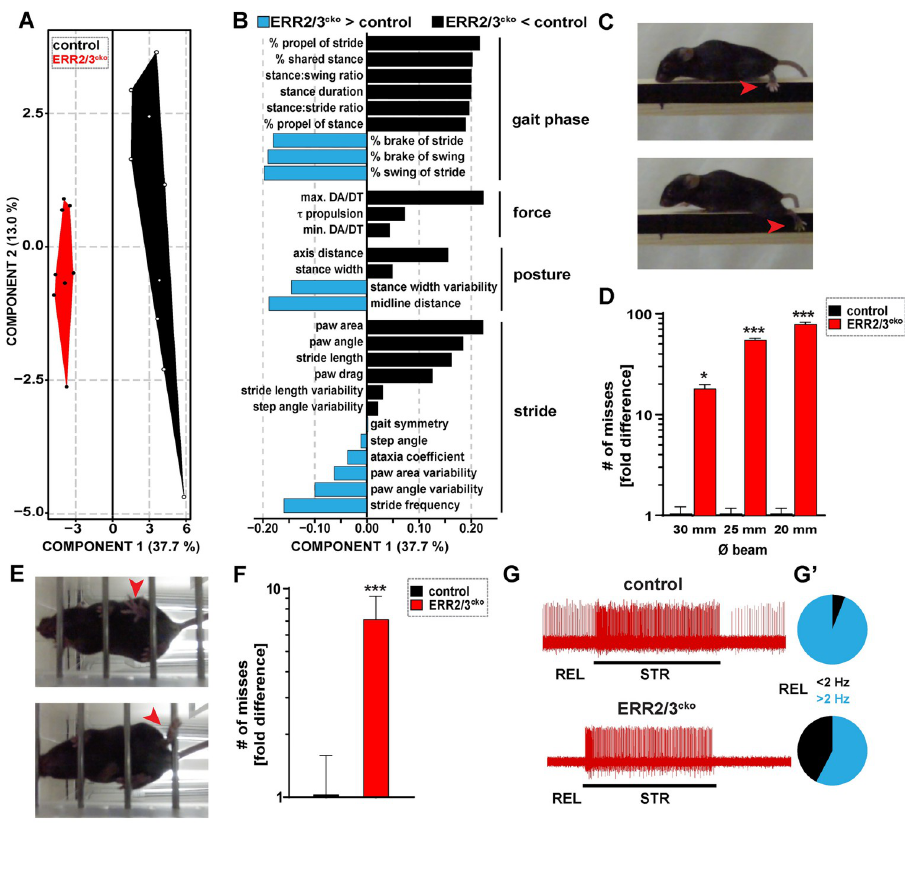
Fig 5. ERR2/3 expressed by gamma motor neurons is required for normal locomotion and precision movements. (A, B) (A) Polygon graphs based on partial least squares (PLS) analysis of 58 gait variables measured during treadmill locomotion at 25 m•s − 1 reveals significant gait alterations in ERR2/3 cko mice ( n = 8, 3 trials/animal) when compared to control mice ( n = 9, 3 trials/animal). Each dot represents a single animal, polygons group animals of the same genotype, the segregation of which along the x-axis indicate that ERR2/3 cko mice exhibit significant gait alterations at all speeds tested (ERR2/3 cko mice, 3 trials each). (B) Negative (black) or positive (light blue) changes (arbitrary units) in gait variables in ERR2/3 cko compared to control mice ranked by predictive value independent of sign, including reduced stance-swing phase ratio (gait phase related), reduced propulsion velocities (force related), decreased stance width (posture related), and increased paw angle variability (stride related). (C) Still images of ERR2/3 cko mouse navigating a horizontal beam. Red arrow: (example of a “miss”): foot missing the beam during swing-stance transition, causing the hind limb and animal to slip during swing phase (red arrow in C ). (D) ERR2/3 cko (18.0 ± 1.75, 55.0 ± 2.20, 79.0 ± 3.49) but not control (1.0 ± 0.175, 1.0 ± 0.125, 1.0 ± 0.125) mice exhibit dramatically increasing erratic locomotion (18-, 55-, and 79-fold increase in the # of misses) upon navigating horizontal beams with decreasing width 30 mm, 25 mm, and 20 mm, respectively (control N = 4, ERR2/3 cko N = 4, 4–5 trials/animal). (E) Still images of ERR2/ 3 cko mouse navigating a horizontal ladder. Examples of a “miss” (red arrow in upper panel): foot missing a rung during swing-stance transition, causing the hind limb to slip during swing phase. Note: Animals frequently attempted to compensate such misses by using the “slipped” hind limb to push against the rung and propel itself forward (red arrow in lower panel). (F) ERR2/3 cko (7.12 ± 2.06) exhibit significantly more Erratic locomotion (7-fold increase in the # of misses) when compared to control (1.0 ± 0.55) upon navigating horizontal ladder (control N = 5, ERR2/3 cko N = 5, 4–5 trials/animal). (G) Example traces showing Ia spindle afferent responses during resting length (REL) or stretch (STR) applied by force transducer: normal STR responses, but reduced REL firing of Ia afferents in ERR2/3 cko mice ( N = 10) when compared to control mice ( N = 10). ( G’ ) Pie charts: ratio of Ia afferents firing above or below 2 Hz at REL (total trials: control n = 84, ERR2/3 cko n = 118; control > 2 Hz n = 79, ERR2/3 cko > 2 Hz n = 68). Data are presented as mean ± SEM. N = # of mice, n = # of 1a afferents. Statistically significant differences between control and ERR2/3 cko mice are indicated as: � p < 0.05, �� p < 0.01, ��� p < 0.001, n.s. = not significant, Student t test). Data for Fig 5A, 5B, 5D, and 5F can be found in S3 Data.